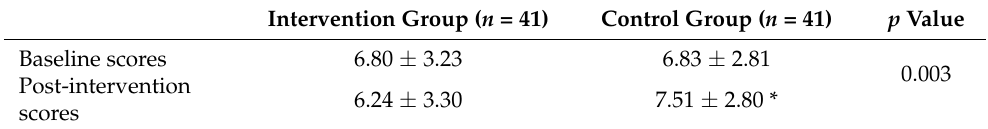
Table 3. Caregiver Strain Index scores of family caregivers before and after the intervention. Intervention Group ( n =